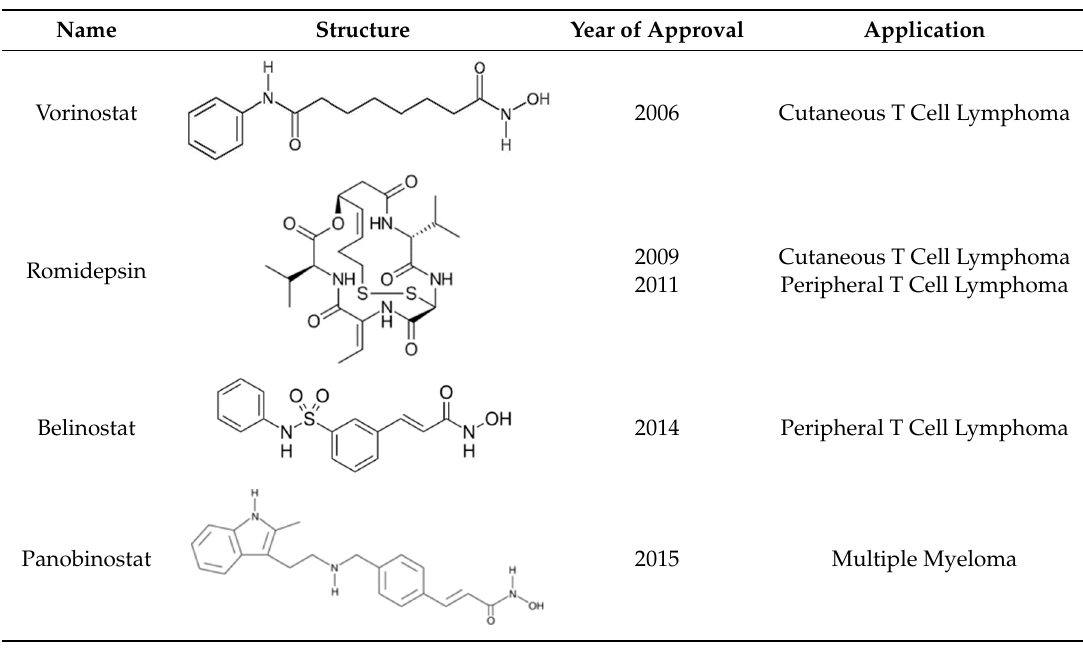
Table 2. Structure and applications of the four food and drug administration (FDA)-approved histone deacetylase inhibitors.